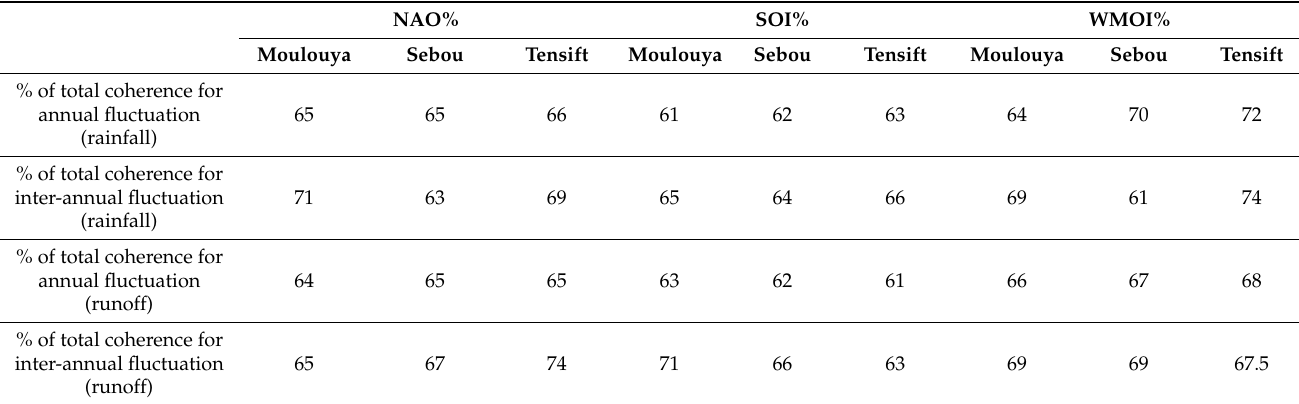
Table 5. Percent contribution of climate